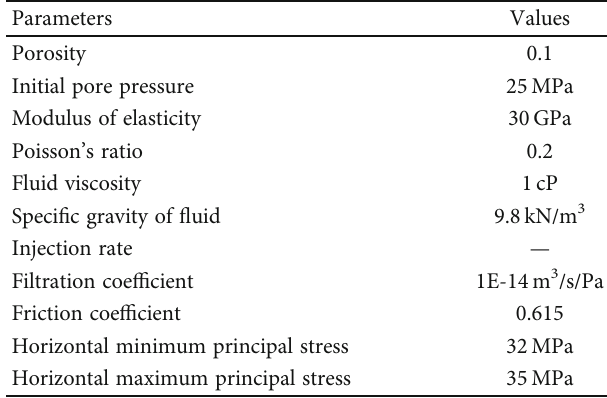
Table 1: The main input parameters in the